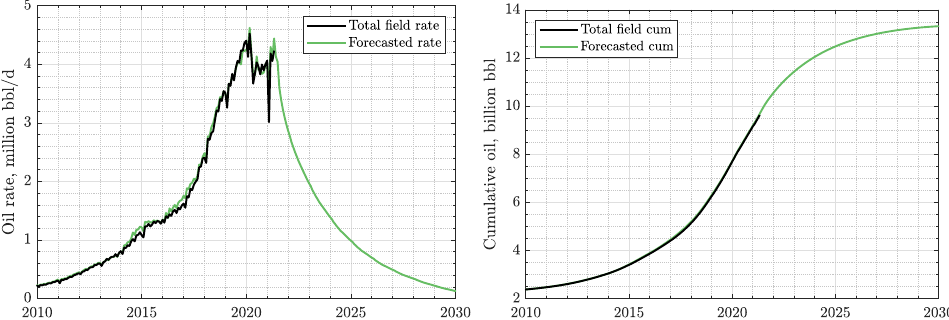
Figure 9. Base case forecast of oil production from 53,708 existing horizontal wells completed in the Permian tight reservoirs. The estimated ultimate recovery is about 13.4 billion bbl of oil.